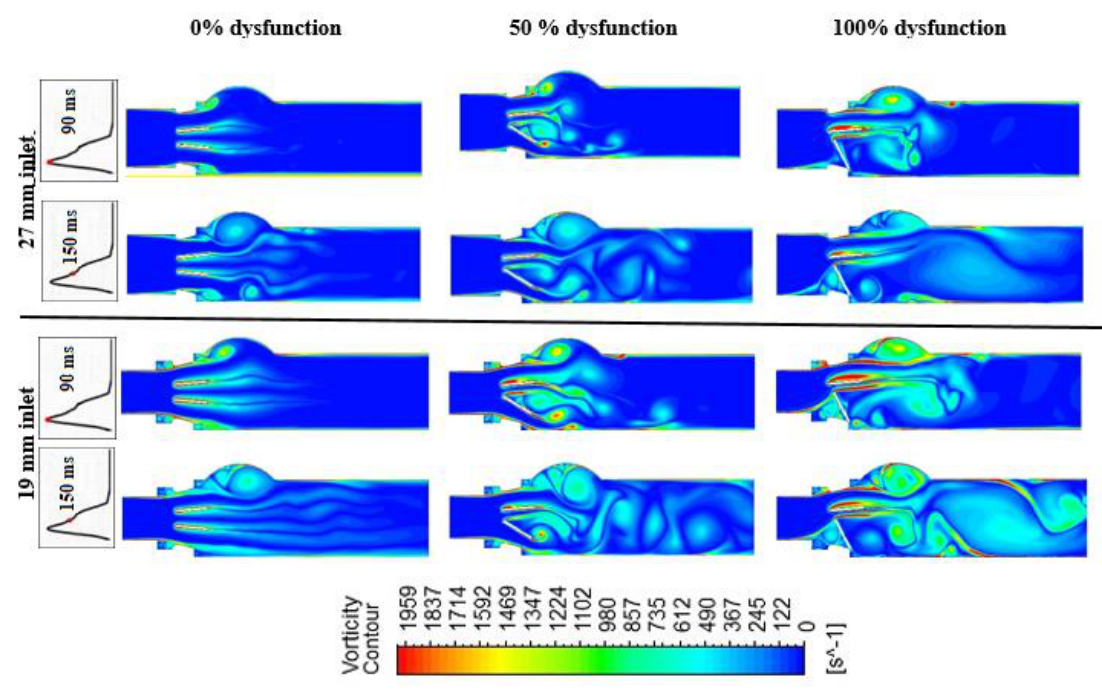
Figure 7. Vorticity distributions downstream of a healthy and dysfunction heart valve for both 27 mm and 19 mm inlet diameter at Q = 7 L / min and two time instances: peak time (90 ms) and during and 19 mm inlet diameter at Q = 7 L/min and two time instances: peak time (90 ms) and during deceleration time (150 deceleration time (150 ms).